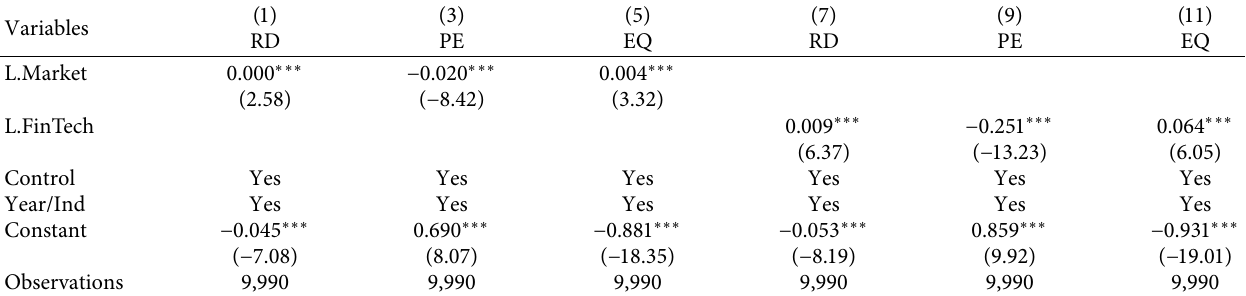
Table 15: Results of one-period lagged regression of explanatory